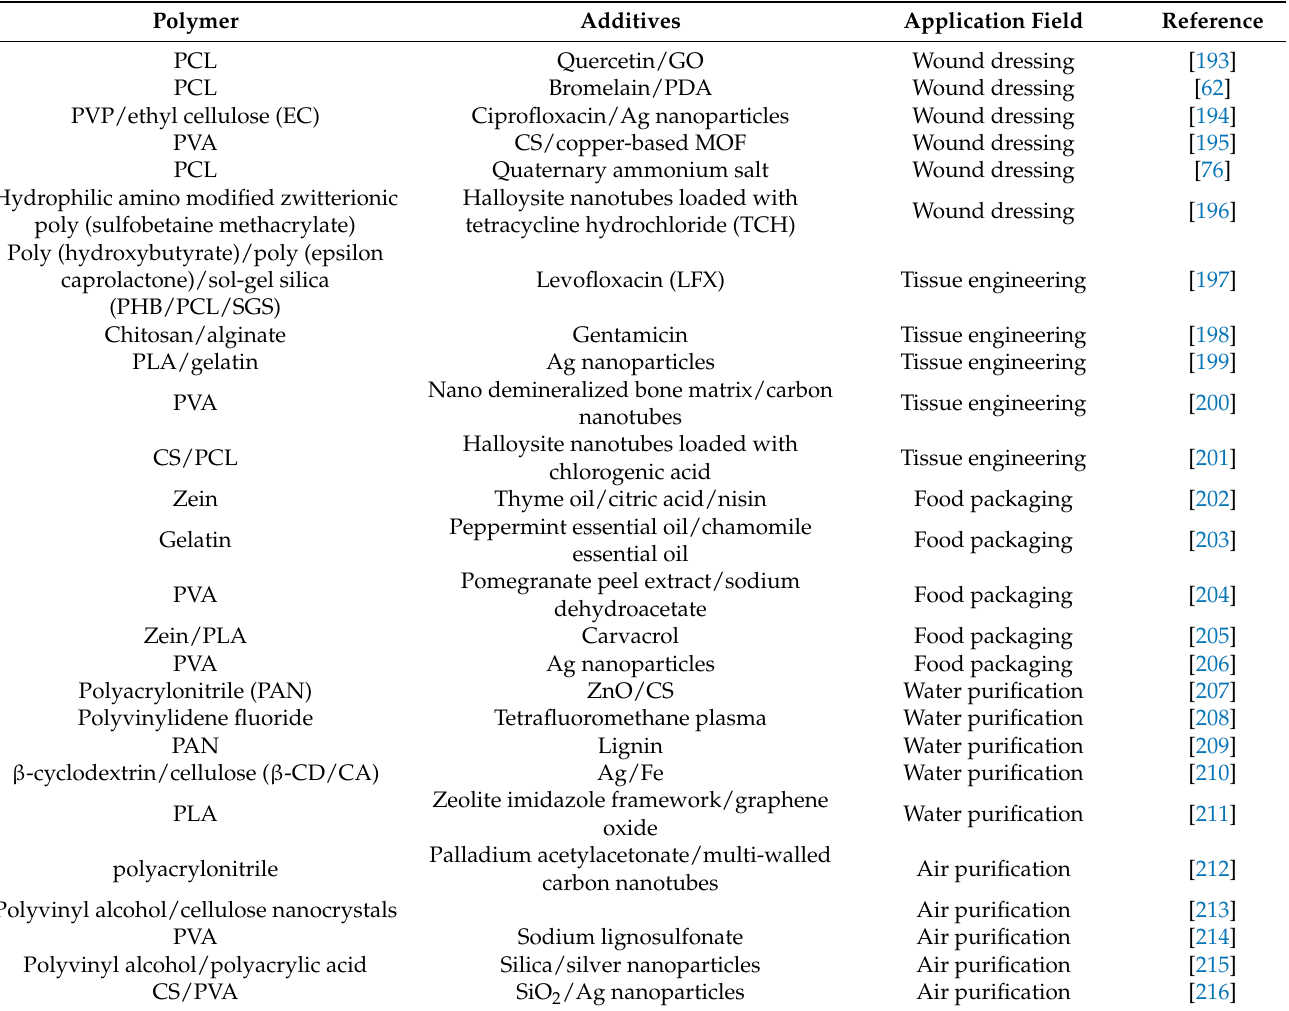
Table 2. Application of electrospinning antibacterial nanofibers in various